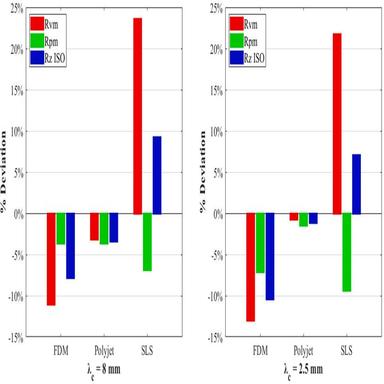
Linear roughness maximum values % deviation for λc = 8 mm (left) and λc = 2,5 mm (right).